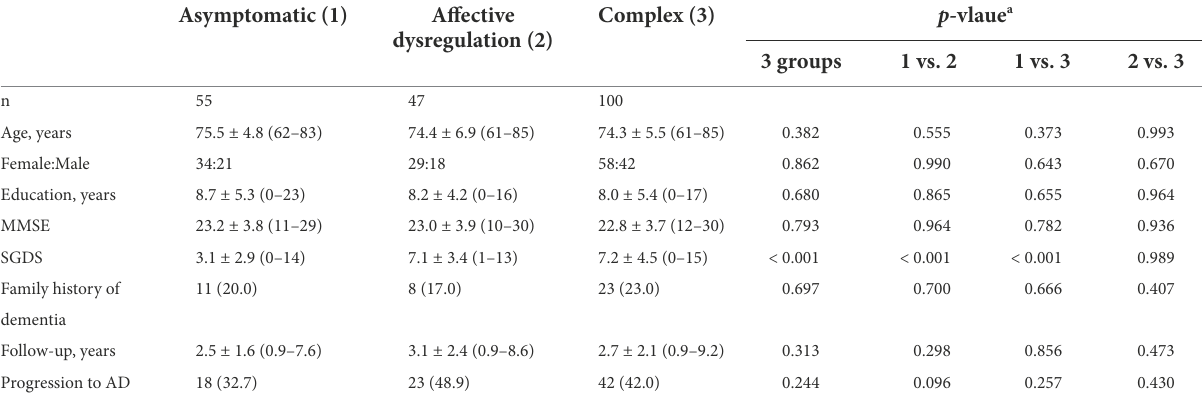
TABLE 5 Demographic and clinical characteristics of the study participants with MRI scans classified based on profiles of MBI domain symptoms. Asymptomatic (1) Affective Complex dysregulation (2)